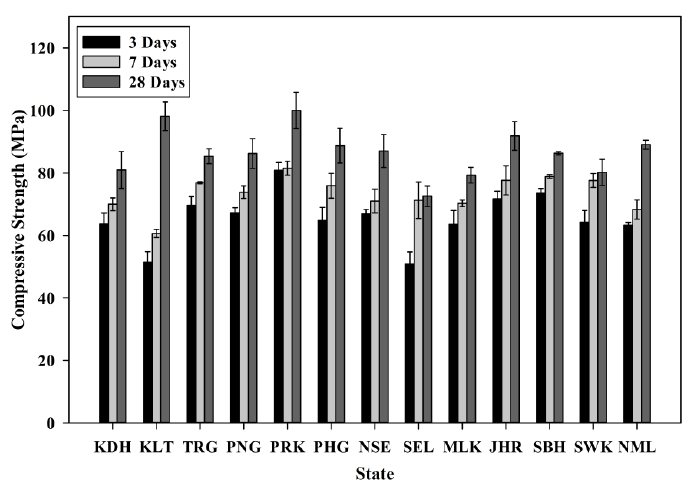
Figure 13. Compressive strength for all states.